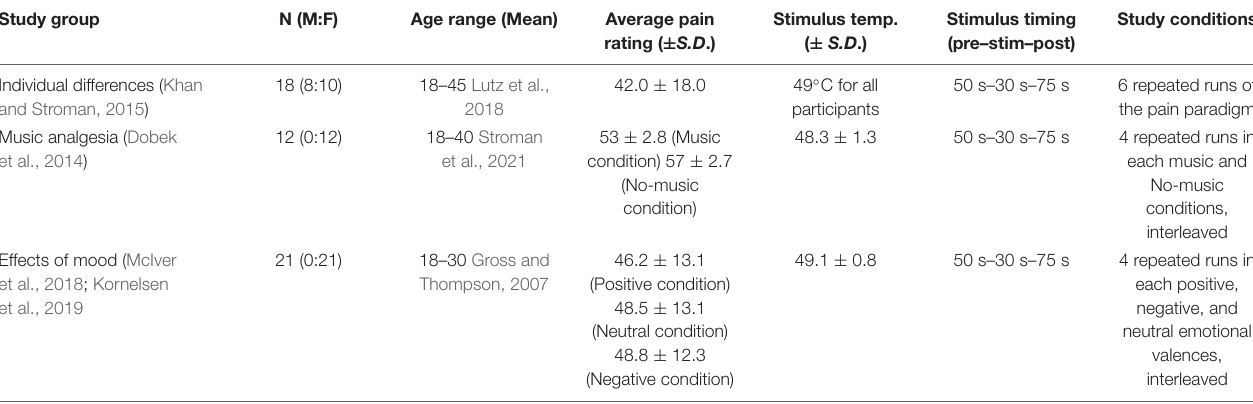
TABLE 1 | Study group demographics and details of stimulation